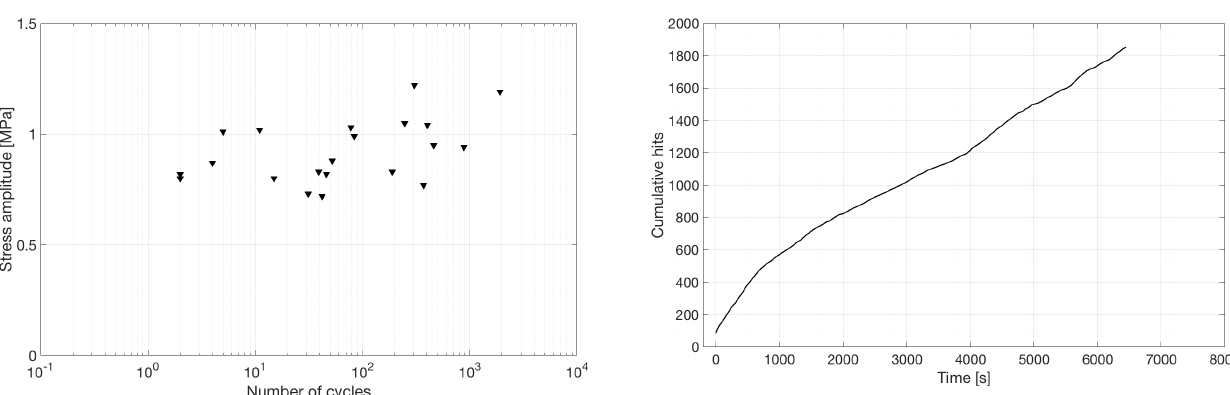
Figure 11. Stress amplitude as a function of the number of cy- cles to fatigue fracture for saline ice of lower salinity (3.0 ± 0.9ppt) tested at − 10 ◦ C and 0.1mms − 1 outer-fiber center-point displace- ment rate.